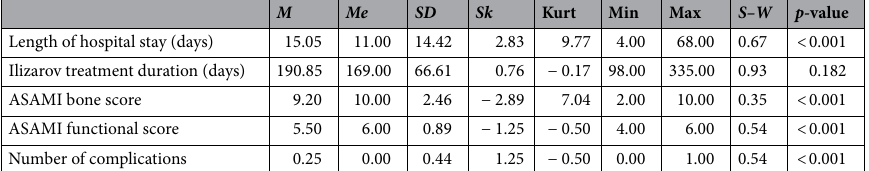
Table 5. Descriptive statistics and Shapiro–Wilk test results for quantitative variables in the patients who underwent closed fixation procedures with subsequent continued compression (n = 20). M mean, Me median, SD standard deviation, Sk. skewness, Kurt. kurtosis, Min minimum, Max maximum, S–W Shapiro–Wilk test result, p-value significance of normality of distribution.